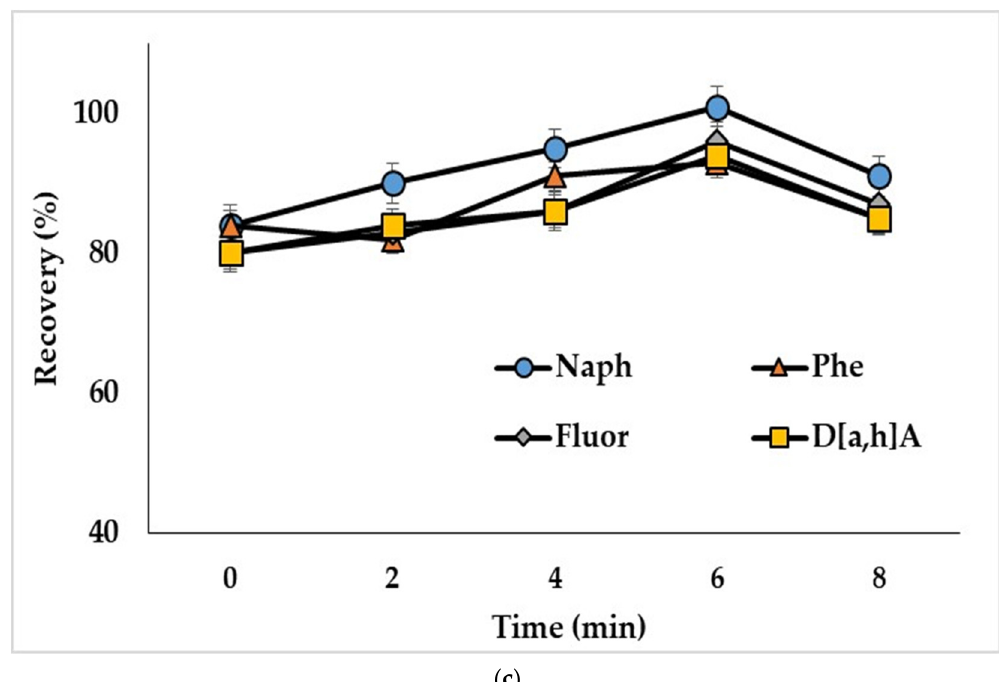
Figure 4. Effect of ultrasonication time on the recoveries of PAHs with extraction mixture: ( a ) chloroform and acetonitrile (mixture I); ( b ) chloroform and methanol (mixture II); ( c ) chloroform and acetone + acetonitrile (mixture III). Concentration of the analytes: 2.5 ng/mL.